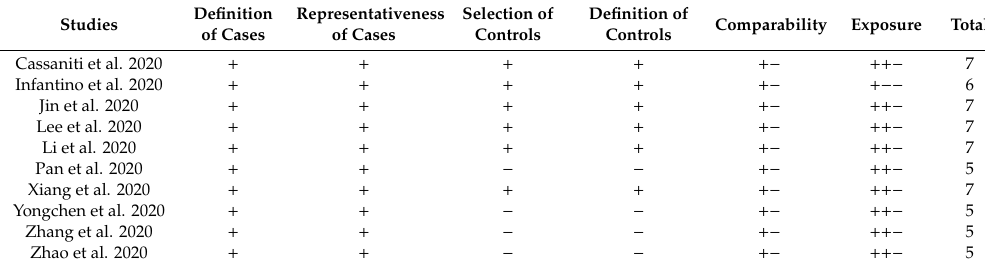
Table 1. Quality evaluation of the included articles.